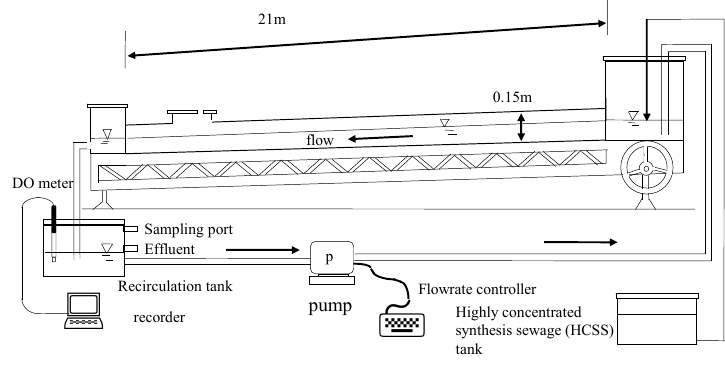
Figure 1. Pilot sewer pipe.